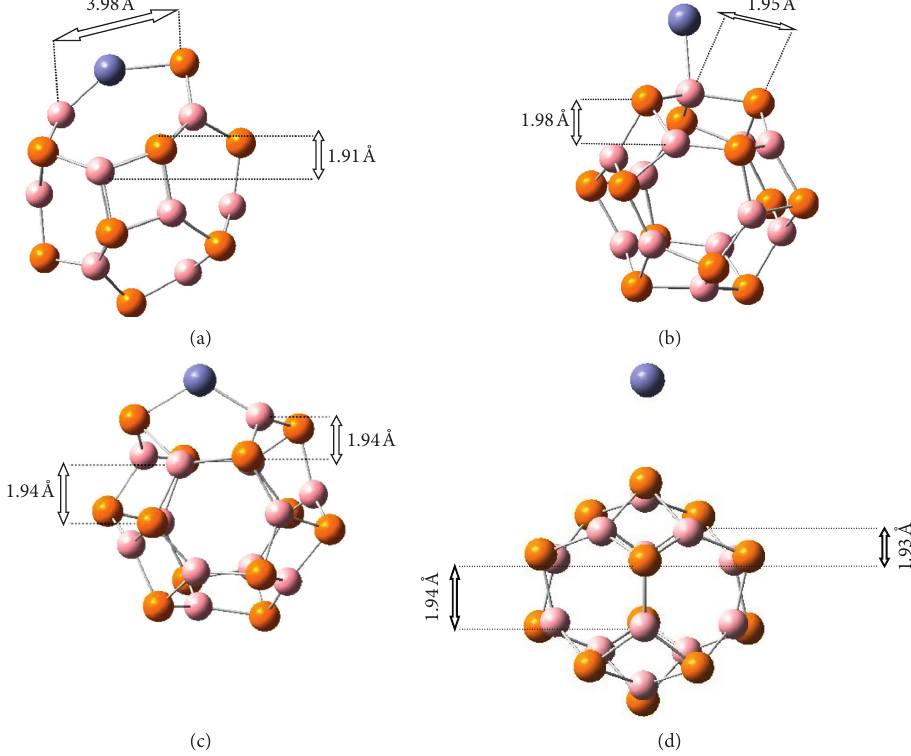
Figure 2: Optimized structures of Zn-doped B 12 P 12 nanocages: (a) M1, (b) M2, (c) M3, and (d)